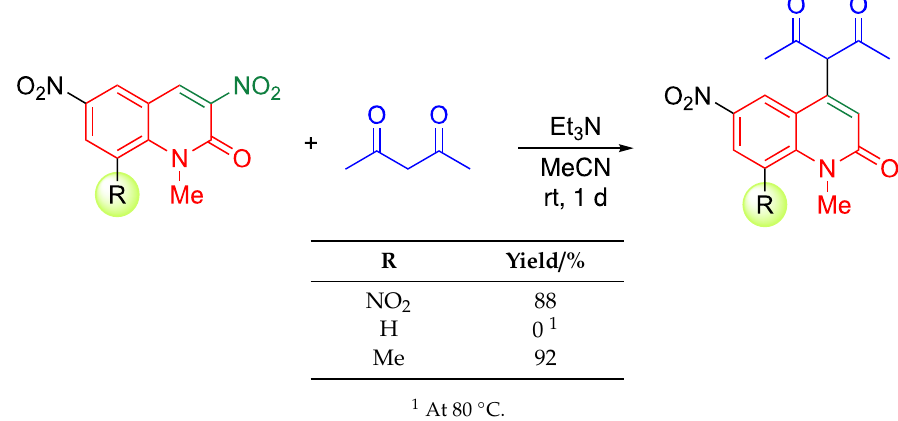
Table 7. Effect of the substituent at the 8-position for the cine -substitution.